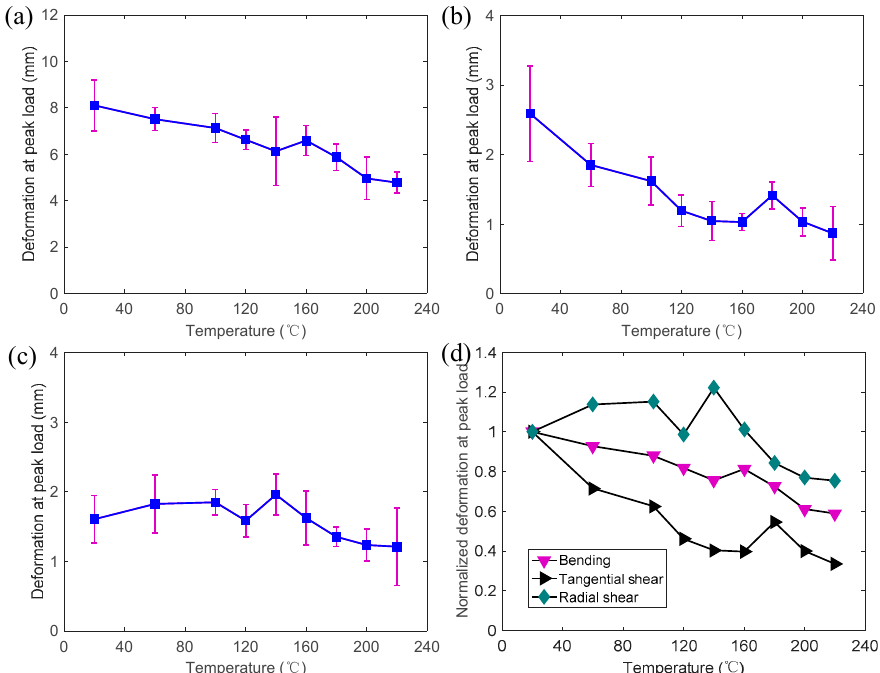
Figure 13. Temperature-dependent deformation at peak loads with standard deviations (purple line): ( a ) bending; ( b ) tangential shear; ( c ) radial shear; ( d ) normalized value.